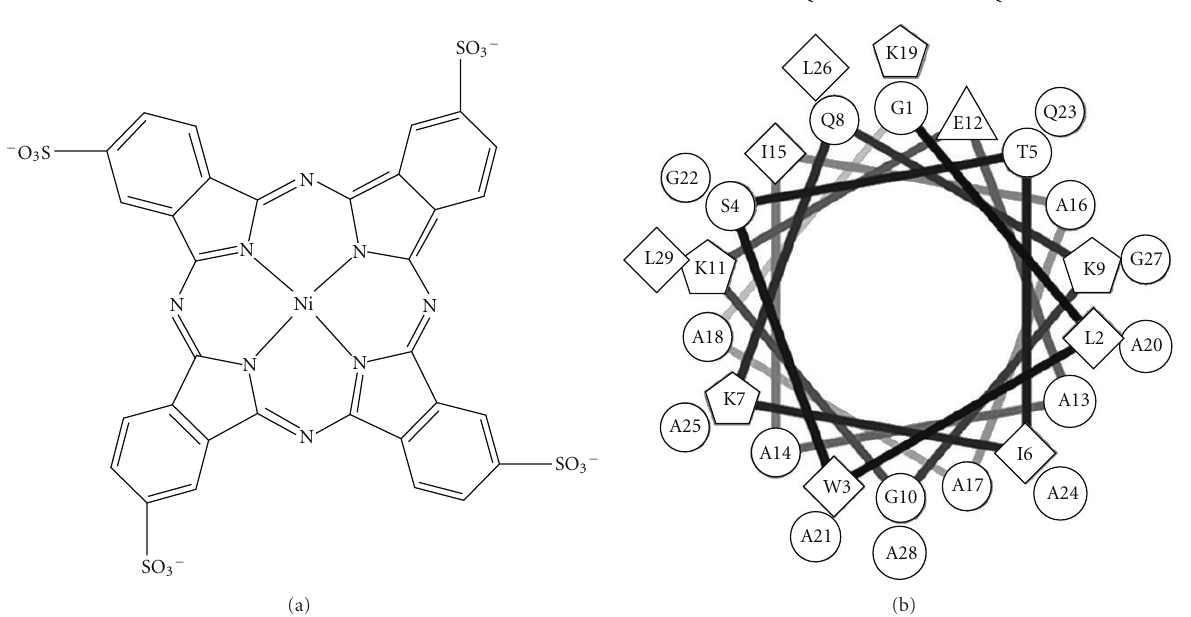
Figure 1: Chemical structures of materials used in LbL films: (a) nickel tetrasulfonated phthalocyanine (NiTsPc) and (b) amino acid sequence and helix-wheel plots of the antimicrobial peptide (DS 01) showing the amphiphilic character of the molecule.